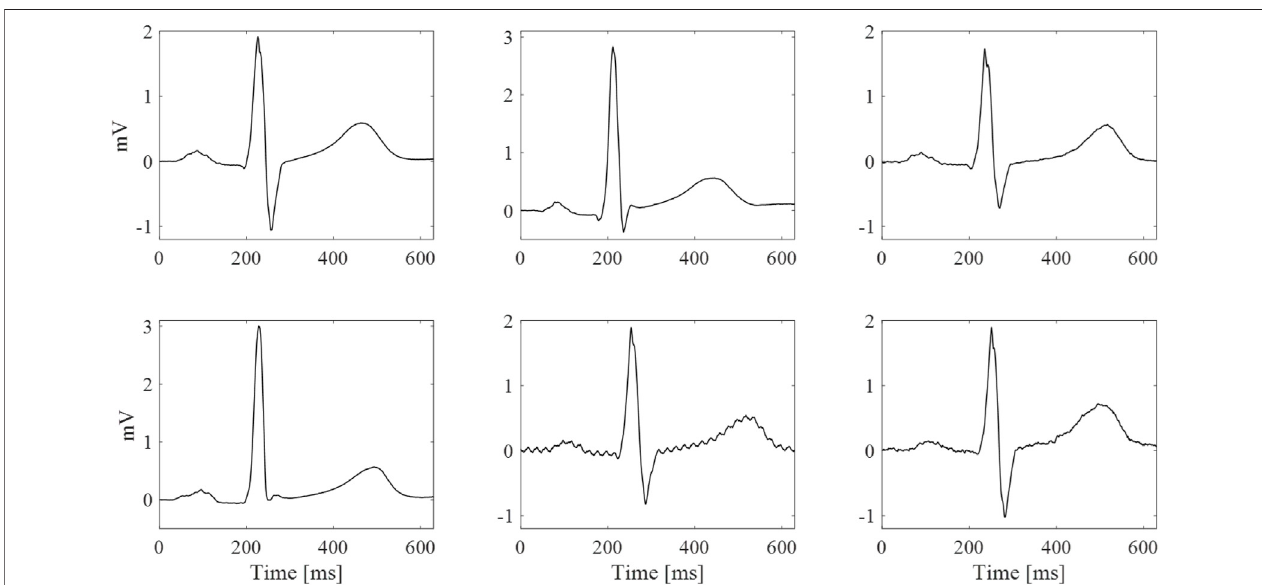
FIGURE 9 | Examples of median beats with the highest (top row) and lowest (bottom row) qualitative scores for the different electrode types (taken from different subjects and not simultaneously). Left column: best commercial gelled Ag/AgCl electrode (score of 10/10 for both). Central column: non-breathable tattoo electrode (highest score 10/10 and lowest score 8/10). Right column: breathable tattoo electrode (highest score 10/10 and lowest score